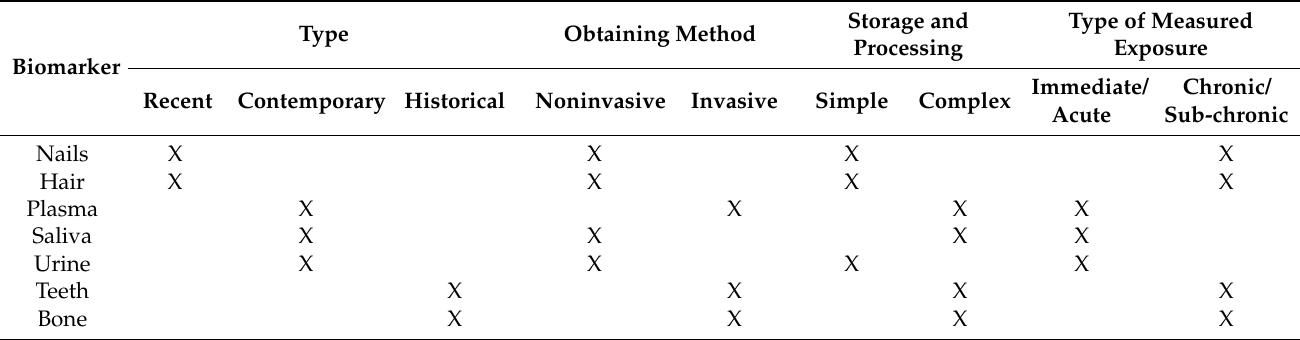
Table 4. Characteristics of the biomarkers employed for monitoring exposure to